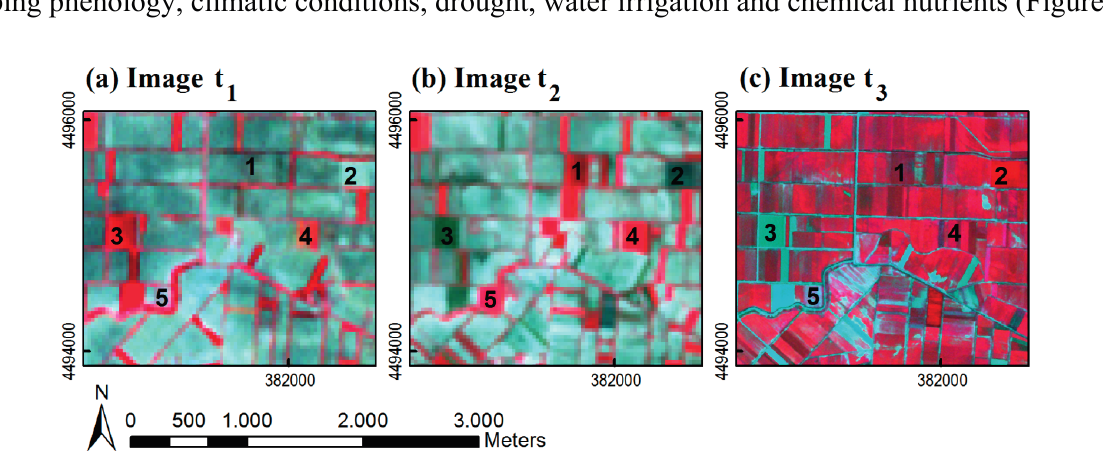
Figure 5. Temporal sequence of images t 1 , t 2 and t 3 covering the same area containing parcels cultivated by various crop types (1 = maize, 2 = rice, 3 = wheat, 4 = alfalfa and 5 = sugarcane). It is indicated that the different phenological states of crops at each time step impose significant variance in the between-class separability.